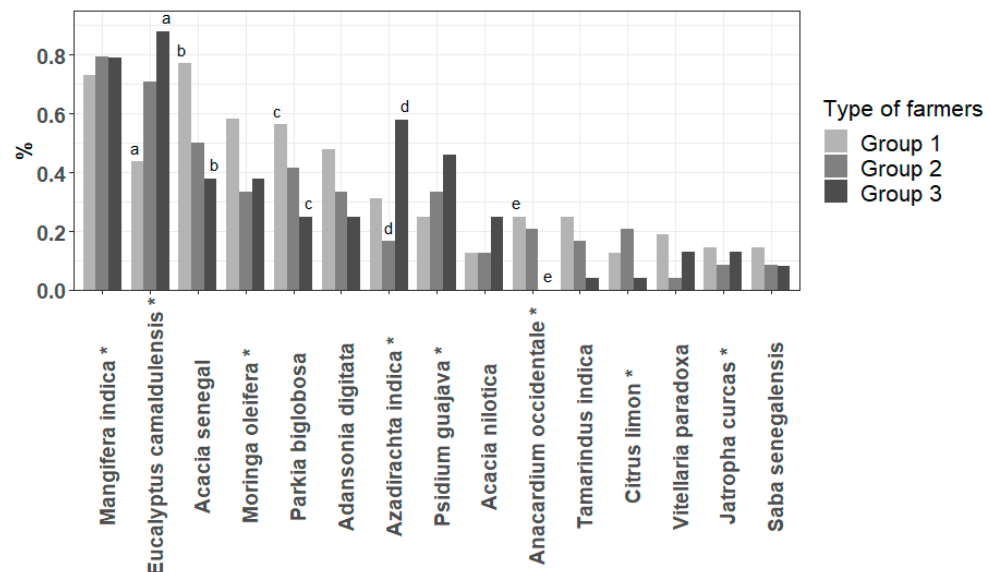
Figure 2. The 15 most frequently planted tree species and the percentage of farmers planting them in each of the three main farmers groups identified: farmers with fences (Group 1), farmers without fences in the municipality of action of tiipaalga (Group 2), and farmers without fences in a different municipality from those where tiipaalga is active (Group 3). Tree species with an asterisk are exotics. Values associated to bars with the same small letter are significantly different from each other (Chi-Square test, p value < 0.05).